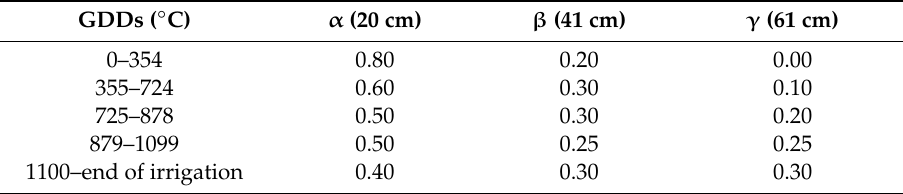
Table 2. Weighted percentages of each sensor according to the Growing Degree Days (GDDs). GDDs ( ◦ C) α (20 cm) β (41 cm) γ (61